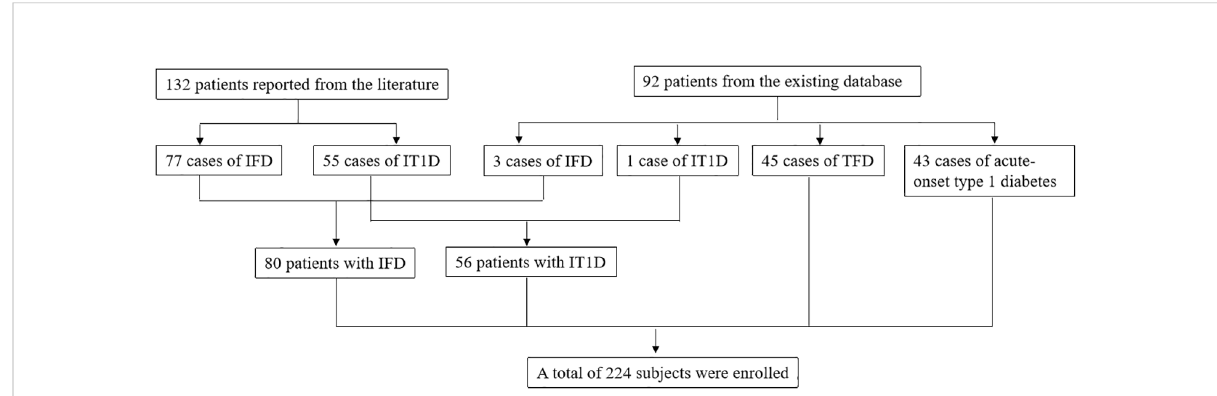
FIGURE 1 Flow diagram of study participants selection. ICI, Immune checkpoint inhibitor; TFD, Traditional fulminant type 1 diabetes; IFD, ICI-associated fulminant type 1 diabetes; IT1D ICI-associated type 1